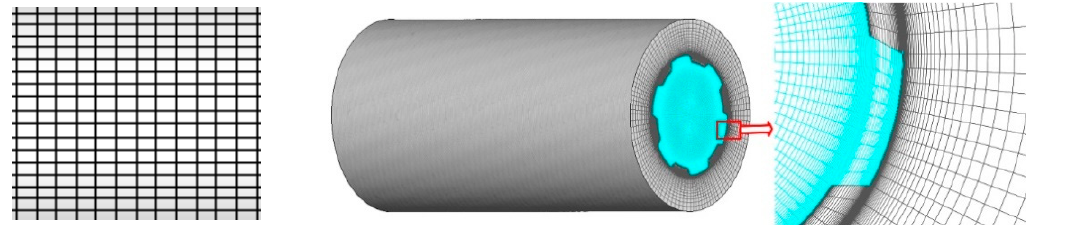
Figure 3. Mesh of IRTs and local mesh in the near-wall region.